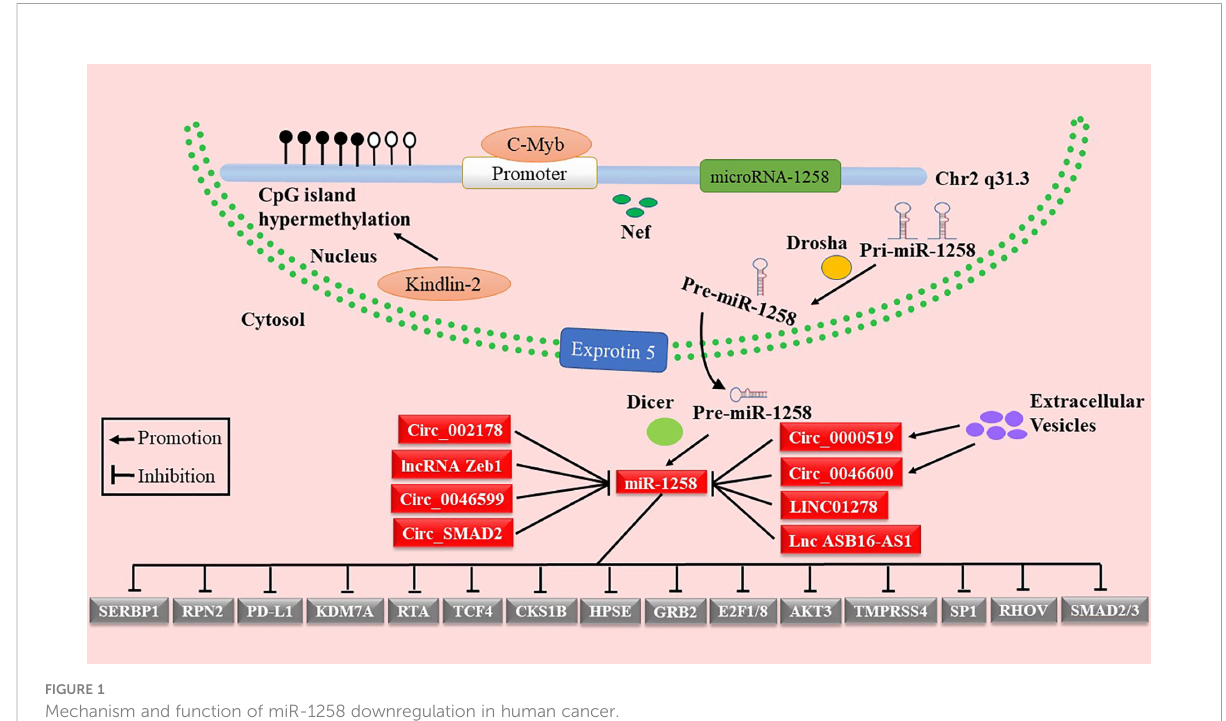
FIGURE 1 Mechanism and function of miR-1258 downregulation in human